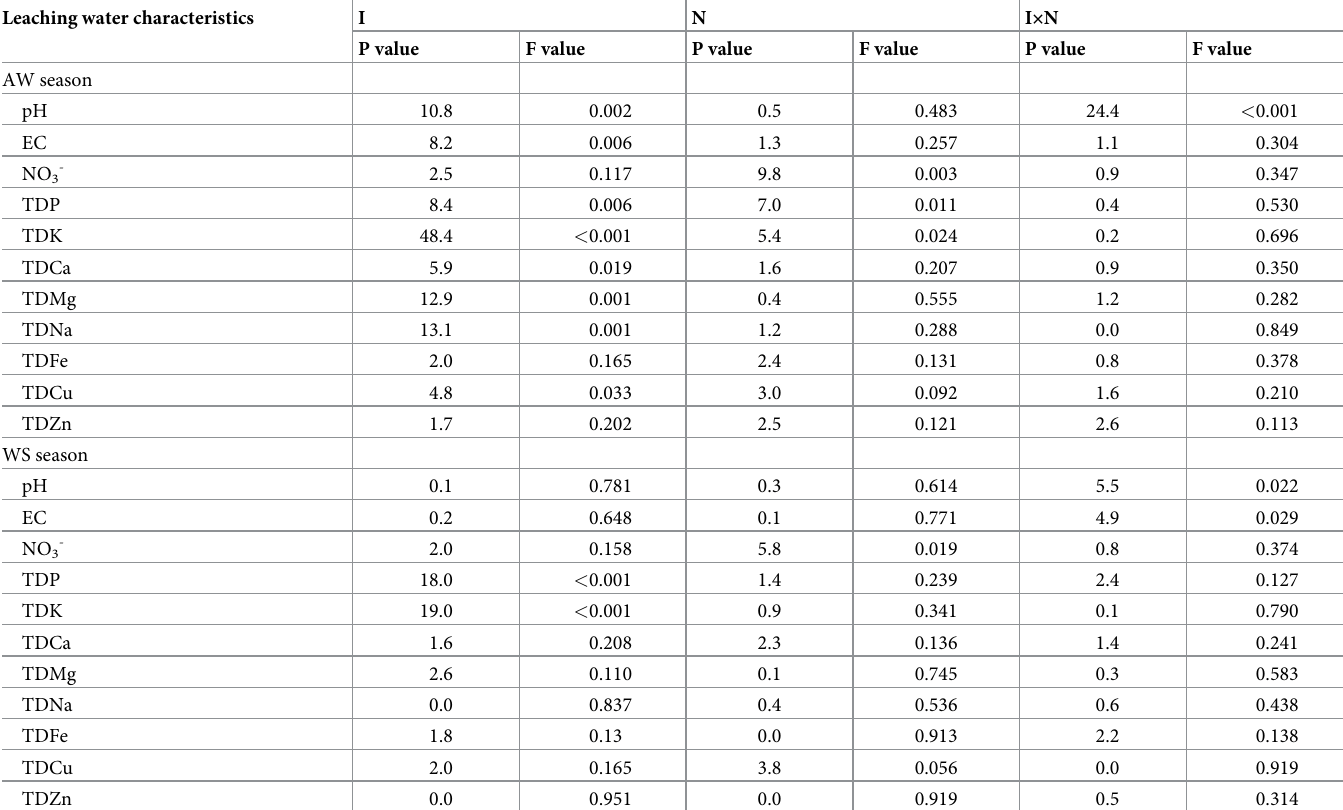
Table 4. Analysis of variance of the effects of irrigation (I) and nitrogen fertilization (N) on concentrations of mineral elements in leaching water in the autumn- winter (AW) and winter-spring (WS) cropping seasons. Leaching water